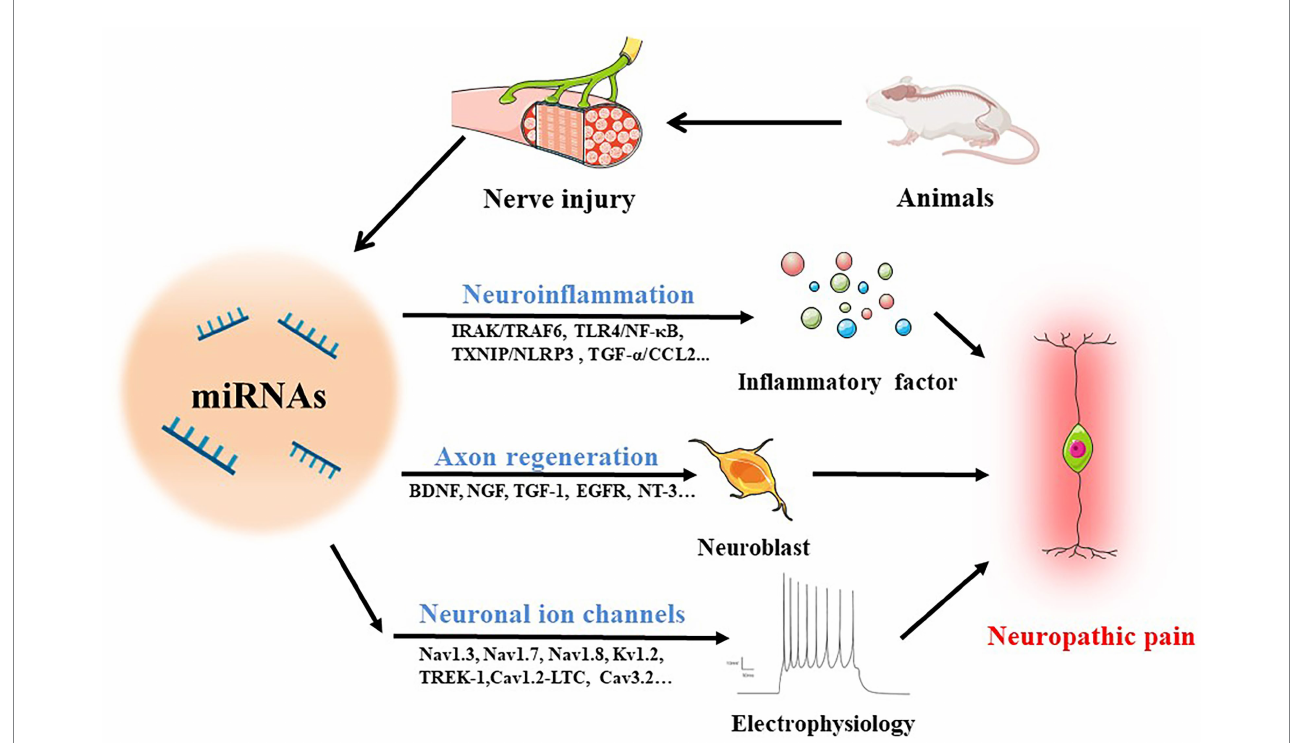
FIGURE 2 MiRNAs in neuropathic pain. The following routes are used by miRNAs to mediate neuropathic pain in animals with damaged nerves: (1) operating on immune cells to stimulate the production of inflammatory cytokines through IRAK/TRAF6, TLR4/NF- κ B, TXNIP/NLRP3, TGF- α /CCL2 and other pathways to regulate neuroinflammation; (2) accelerating axon regeneration by increasing the synthesis of trophic factors such BDNF, NGF, TGF-1, EGFR, and NT-3; (3) mediating neuroelectrophysiological changes by activating ion channels like Nav1.3, Nav1.7, Nav1.8, Kv1.2, TREK-1, Cav1.2-LTC, and